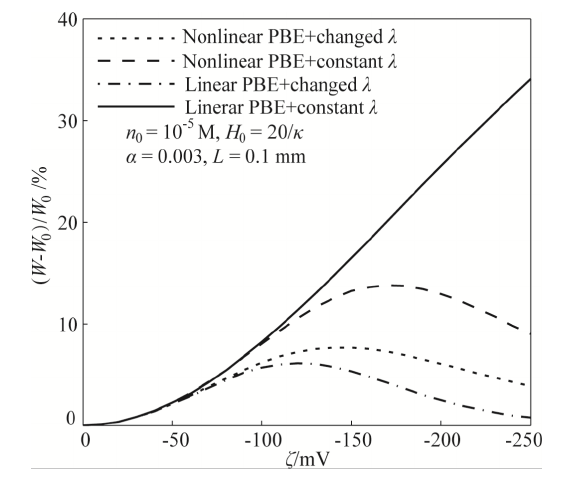
Figure 5: Comparison of the hydrodynamic load capacity of the lubri- cant including the effect of the zeta potential based on different assumptions and theoretical models. The “Nonlinear PBE+changed λ ” is the model established and used in the present work.